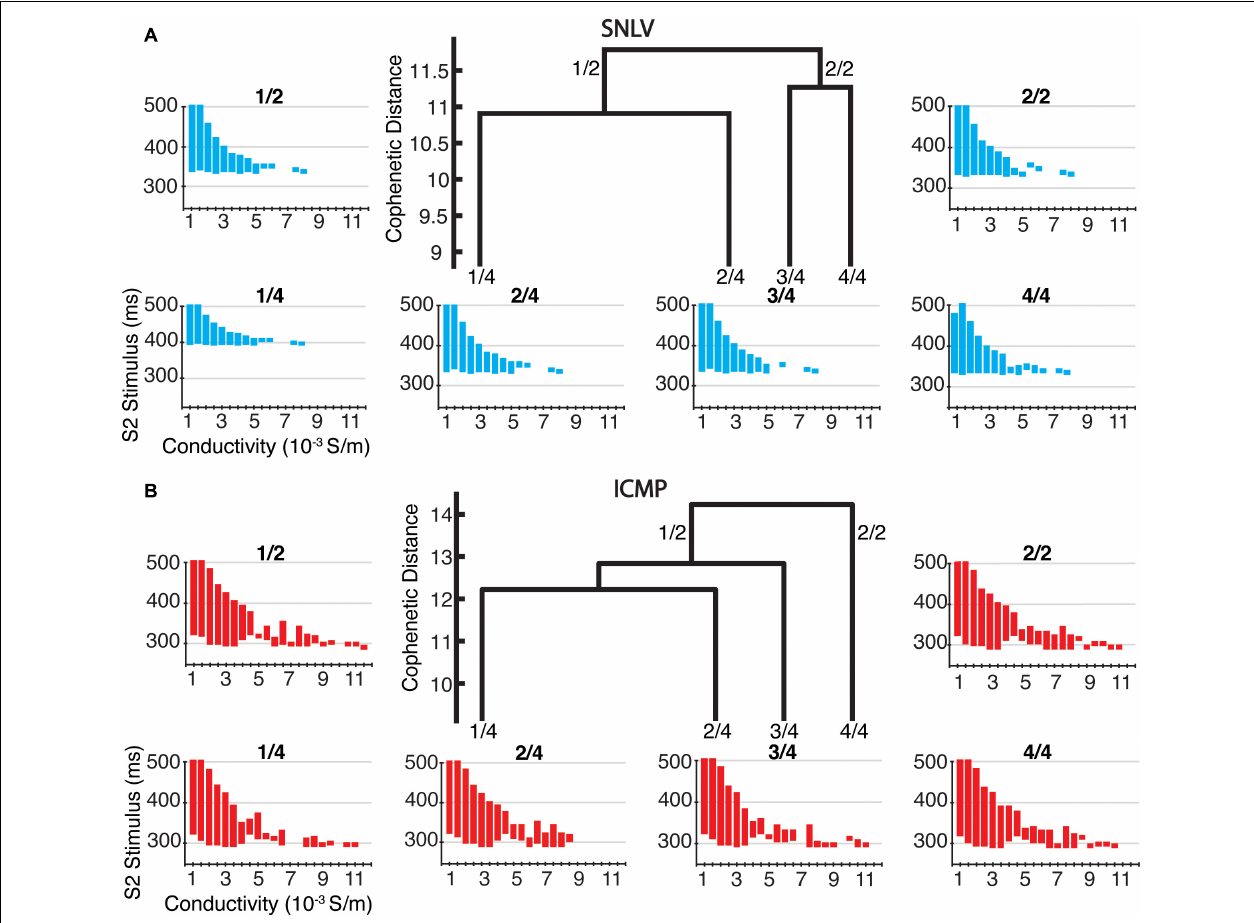
FIGURE 5 | Tissue-level simulations in the two and four highest-level clusters of (A) SNLV and (B) ICMP models. In the center of each sub-plot we show the four highest-level clusters of the dendrogram produced by AHC. The two highest-level clusters are noted as 2/1 and 2/2 and the four highest clusters are noted as 4/1, 4/2, 4/3, and 4/4. Note that for ICMP clusters 2/2 and 4/4 are identical since no bifurcation of the dendrogram occurs at this level. Each plot surrounding the dendrogram shows the S1–S2 coupling intervals that resulted in sustained functional re-entry for different conductivity values and is labeled after the cluster that it has been created from ( X -axis represents different tissue conductivity values in mS/m and Y -axis represents S1–S2 coupling intervals that resulted in sustained functional re-entry). For all clusters, ICMP models developed sustained functional re-entry over a wider range of S1–S2 coupling intervals for the entire range of conductivity values, compared to